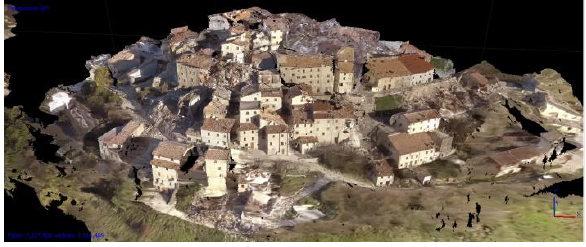
Figure 3. 3D model of Castelluccio after the